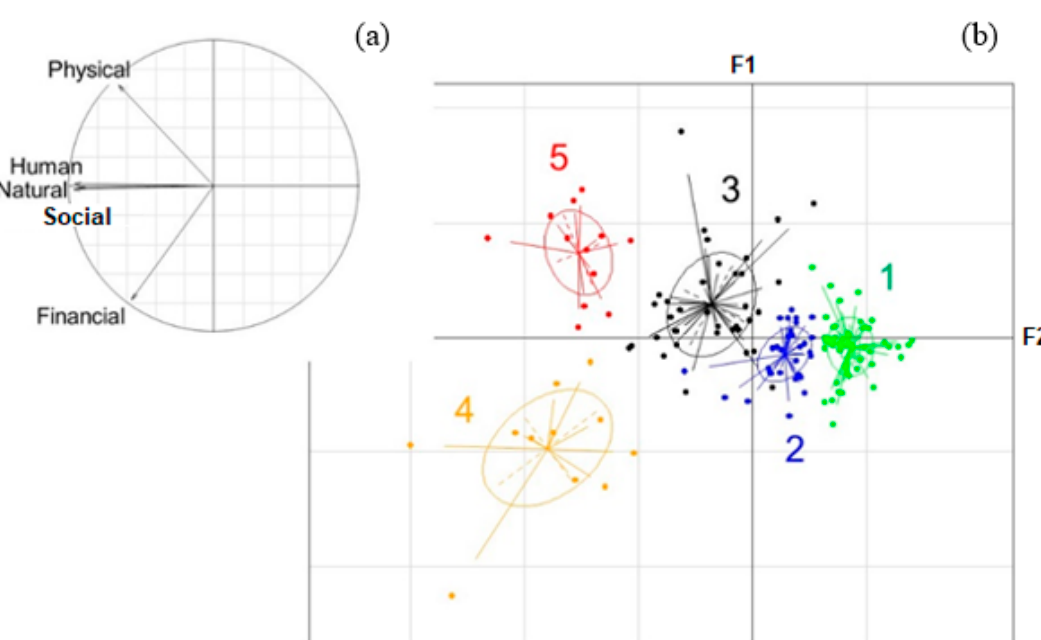
Figure 5. Projection of capital indices ( a ) and farms of the small-scale family agriculture system distributed in five clusters ( b ) in the factorial plane F1F2 of a principal component analysis.